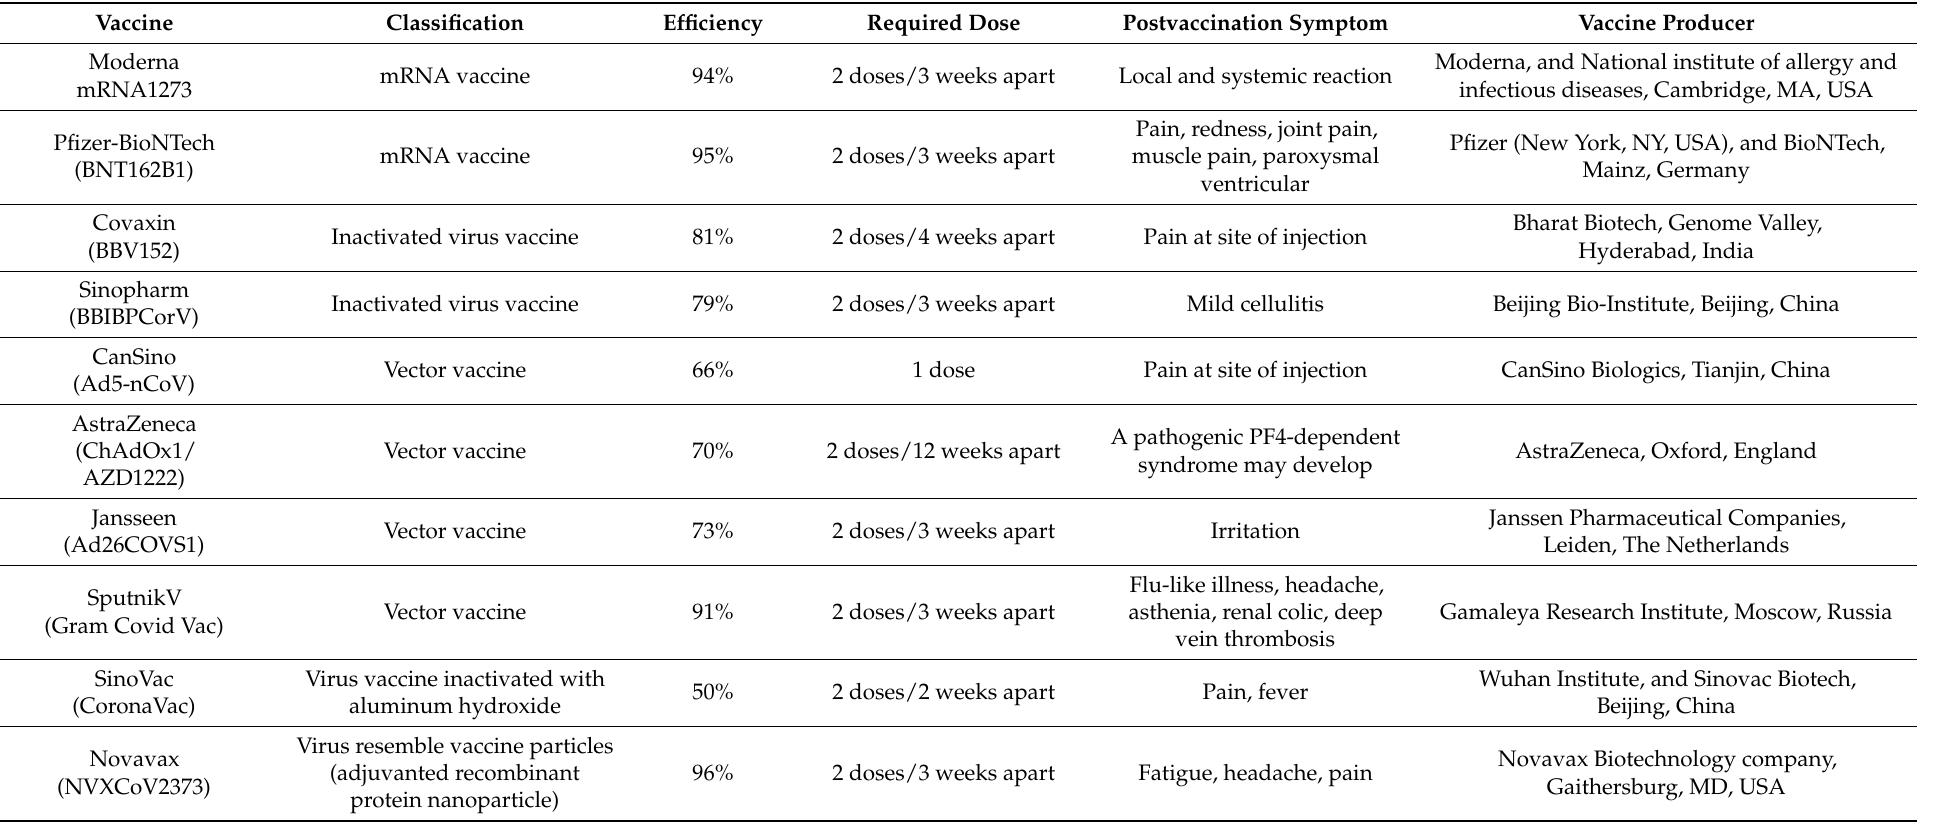
Table 6. Vaccines available against SARS-CoV-2